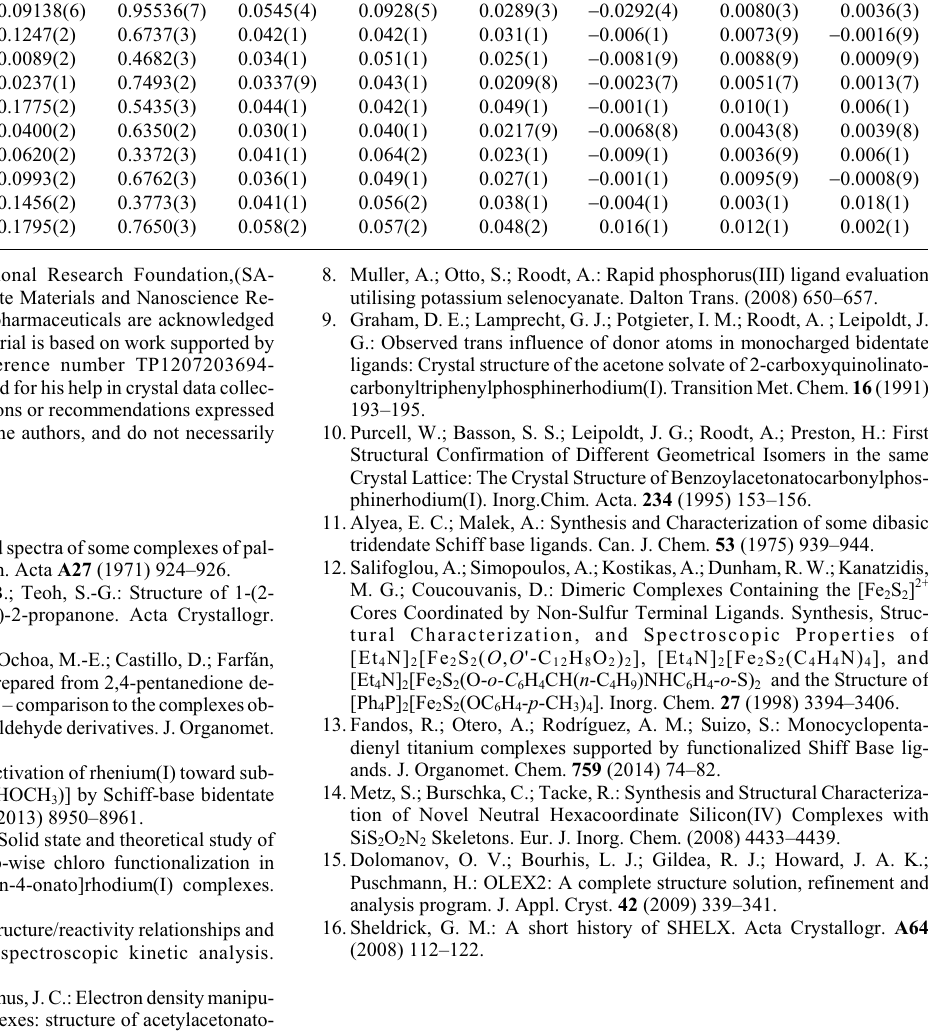
Table 3. Atomic coordinates and displacement parameters (in Å 2 ) .